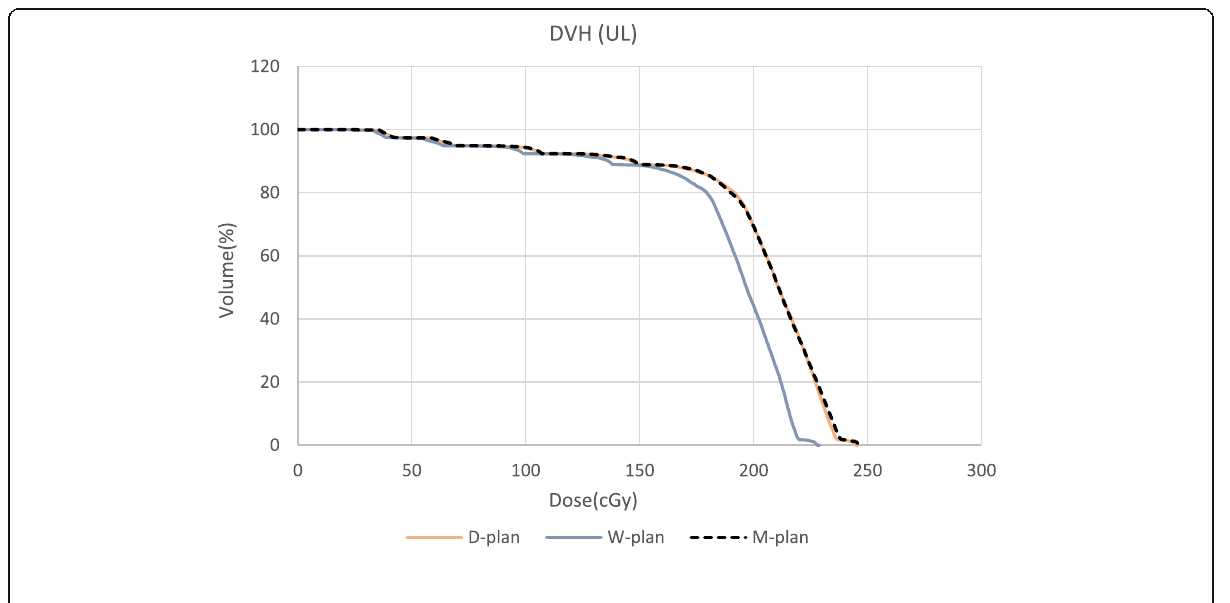
Fig. 3 Comparing DVH of the whole film at the level of crowns in different plans when the implant system